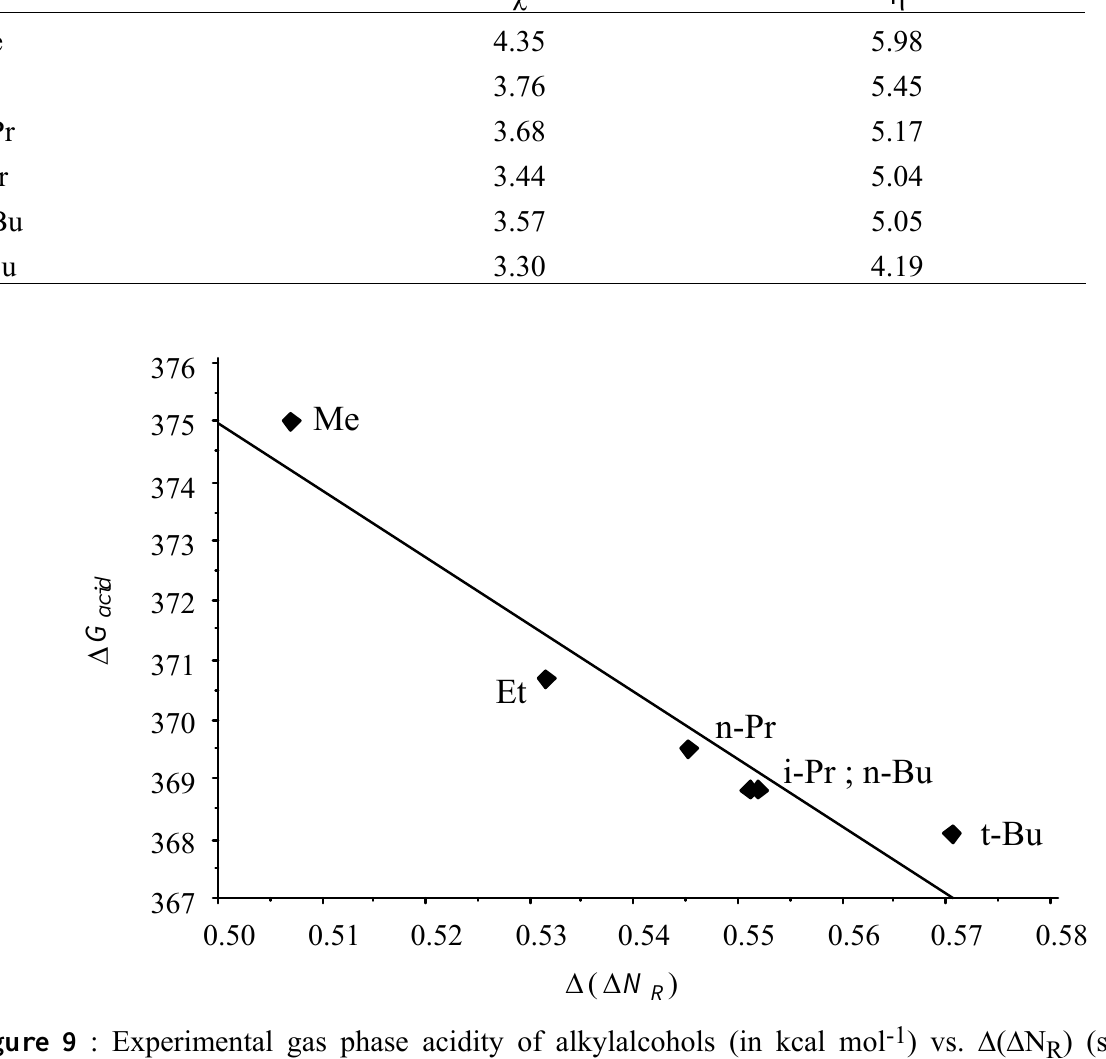
Figure 9 : Experimental gas phase acidity of alkylalcohols (in kcal mol -1 ) vs. ∆ ( ∆ N (reprinted with permission by Pergamon/Elsevier-Reference